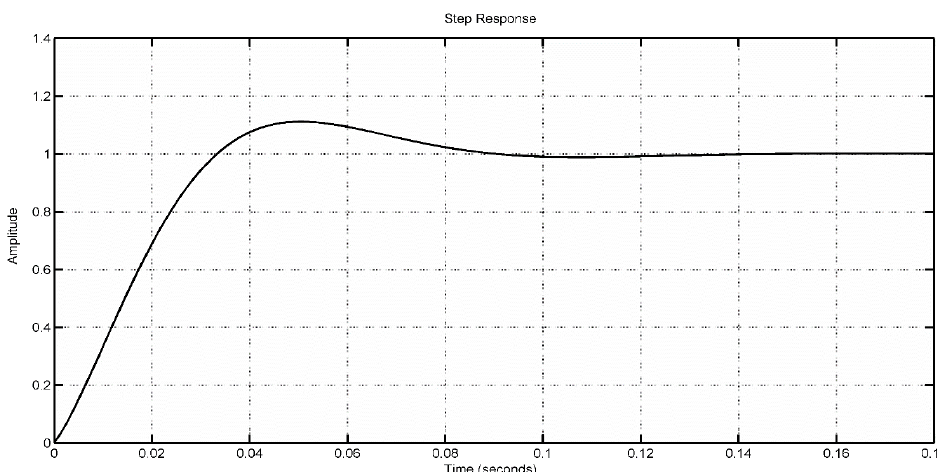
Figure 13. Roll response of the octocopter with the designed proportional-derivative (PD) controller.